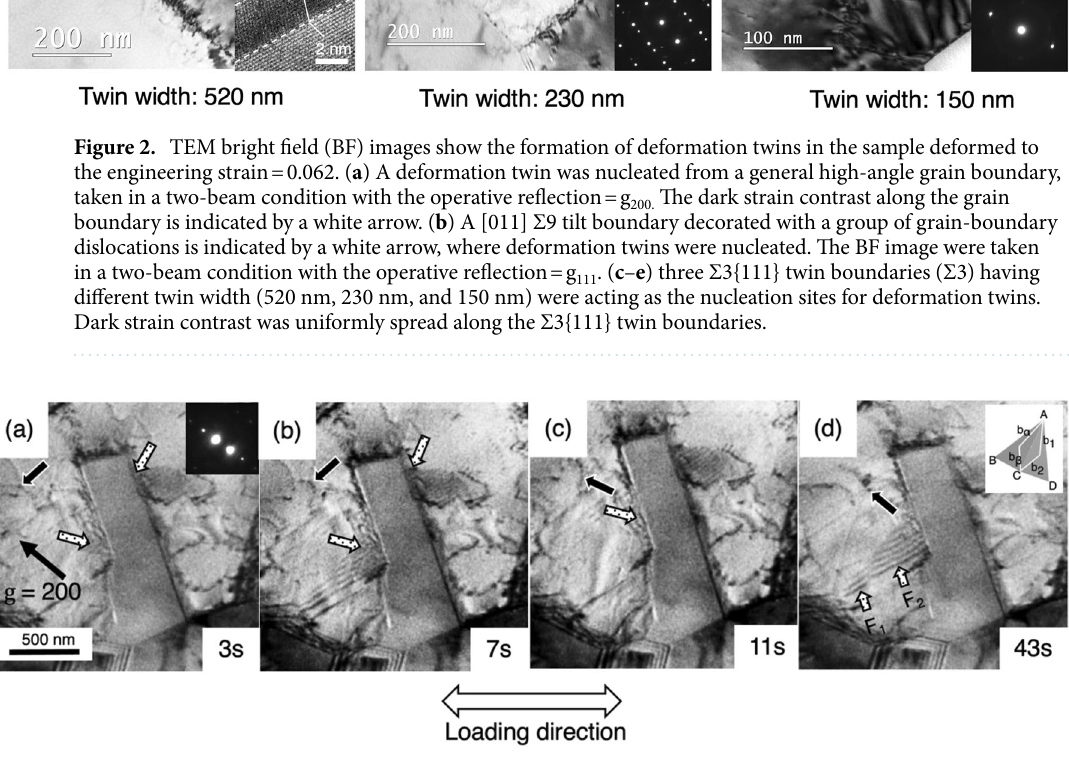
Figure 3. Selected frames of a TEM in-situ deformation test video data showing an area near the Σ3{111} twin boundary. The video (see provided Supplementary Video) was recorded in a two-beam condition with the operative reflection = g 200 . ( a ) The initial stage of a stacking fault emission event. The arrows filled with dots indicates the stacking faults nucleated from the boundaries. ( b – d ) the continuous emission of stacking faults from the Σ3{111} twin boundary. The periodic contrast change was observed during the deformation and may be the result of overlapping of stacking